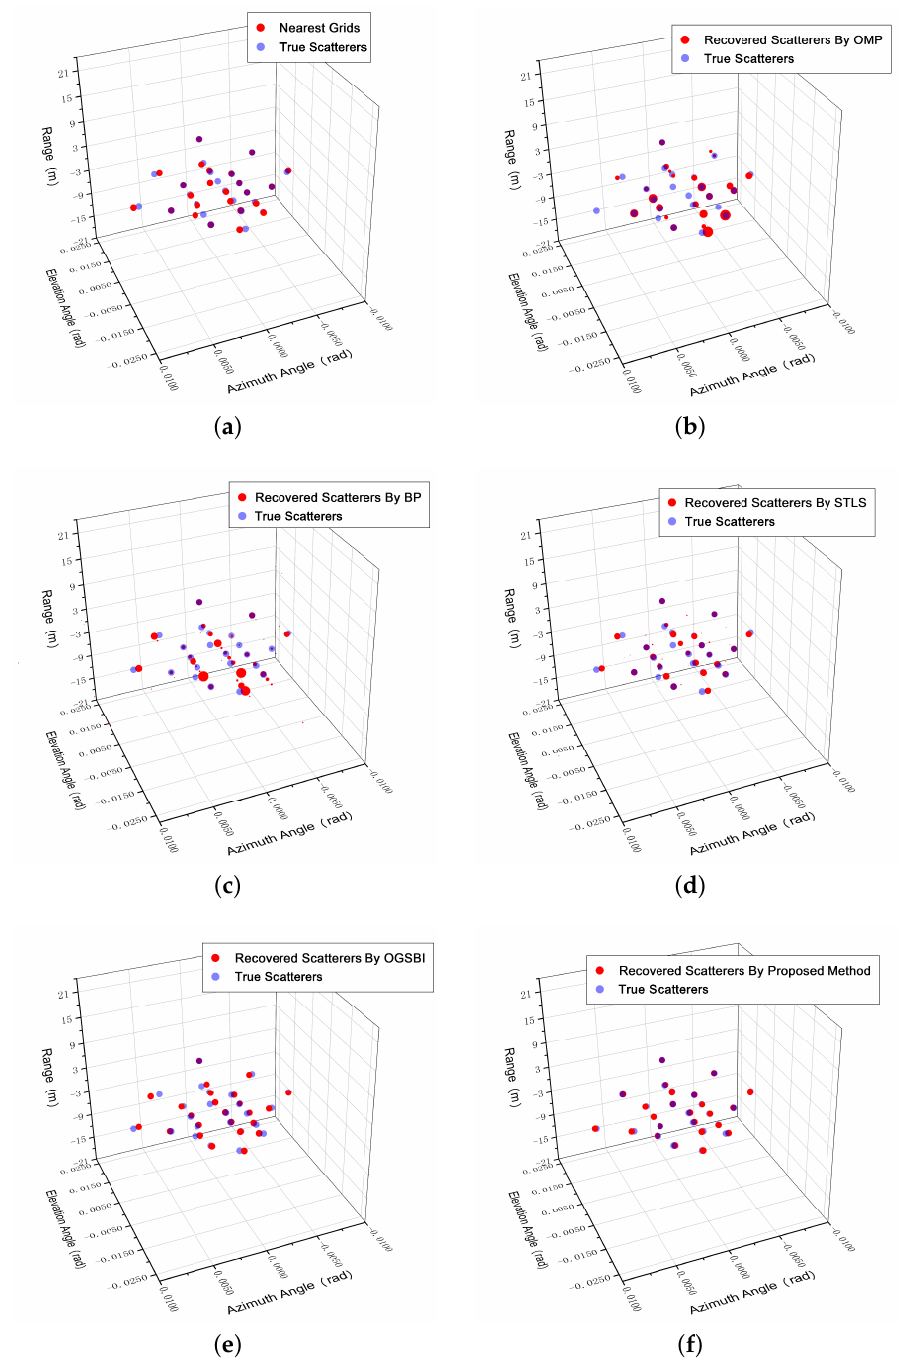
Figure 4. The original target model and reconstructed ones by different algorithms: ( a ) The original target model and the corresponding nearest grids; ( b ) Reconstructed target scatterers by OMP; ( c ) Reconstructed target scatterers by BP; ( d ) Reconstructed target scatterers by S-TLS; ( e ) Reconstructed target scatterers by OGSBI; ( f ) Reconstructed target scatterers by proposed